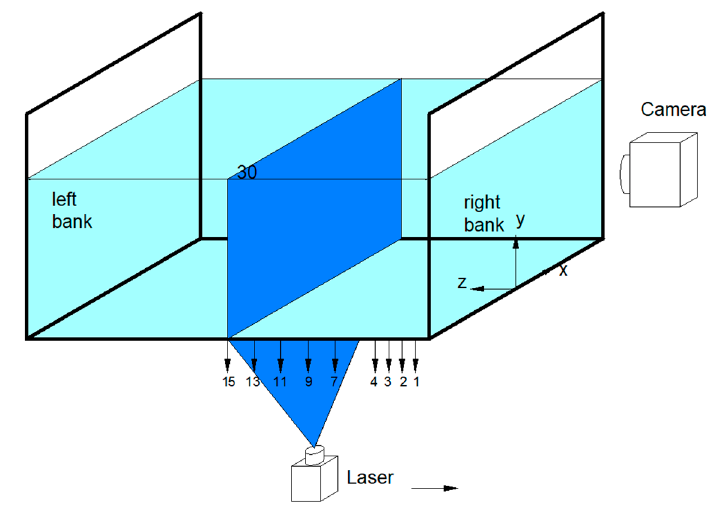
Figure 3. Schematic of the measuring sections and coordinate.